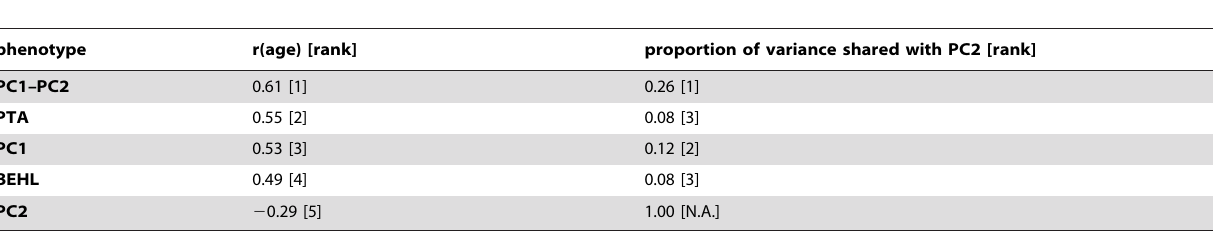
Table 2. Ranking of pure-tone audiogram phenotypes.